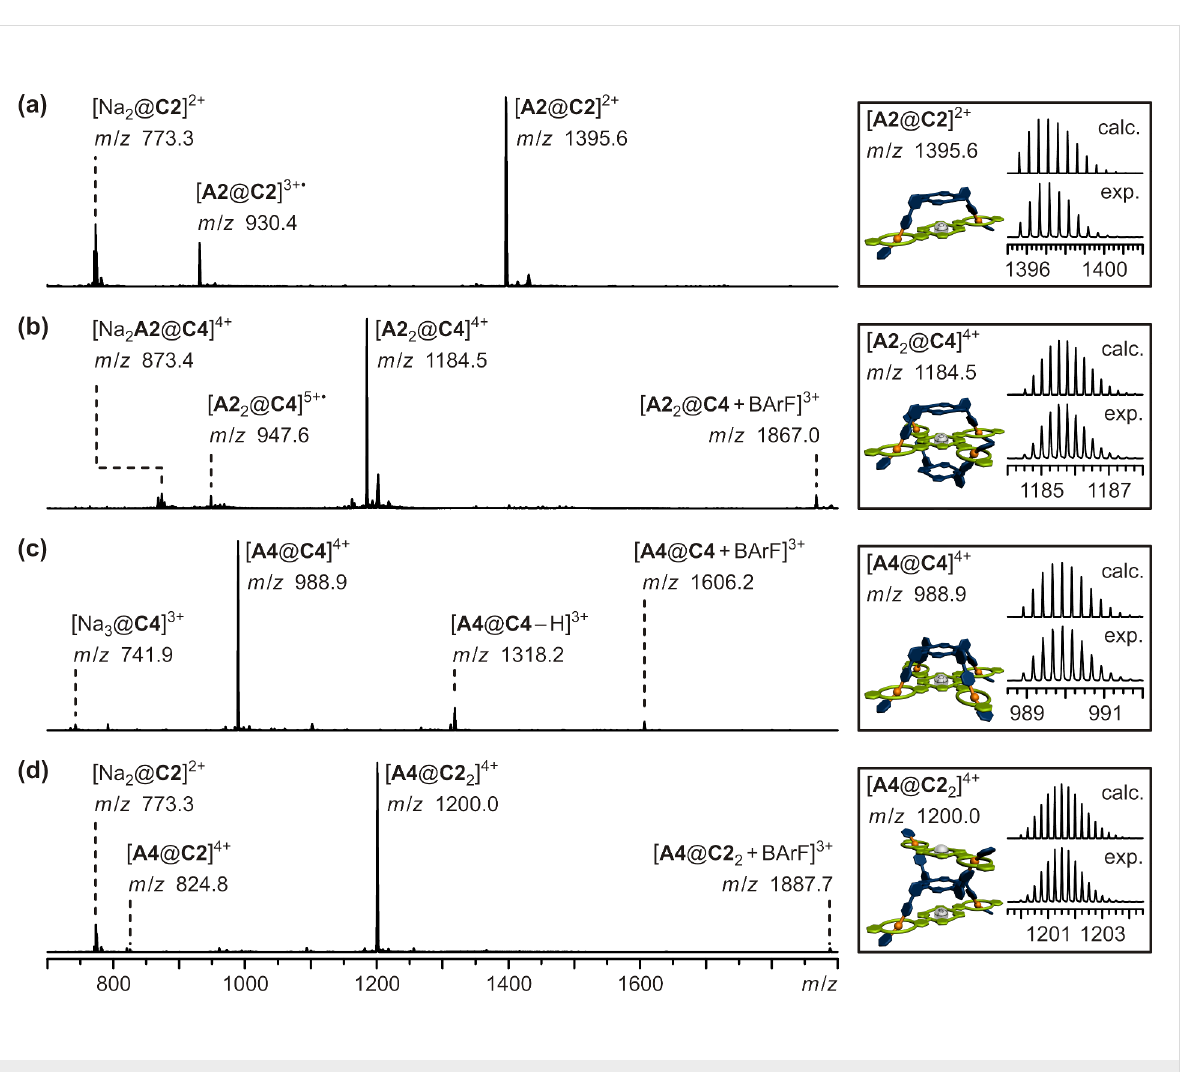
Figure 10: ESI-Q-TOF-MS spectra (CH 2 Cl 2 , 0.2 µM; left hand side) and respective experimental and calculated isotopic patterns of the desired [2]- or [3]pseudorotaxanes (right hand side): a) 1:1 mixture of A2 and C2 , b) 2:1 mixture of A2 and C4 , c) 1:1 mixture of A4 and C4 , d) 1:2 mixture of A4 and C2